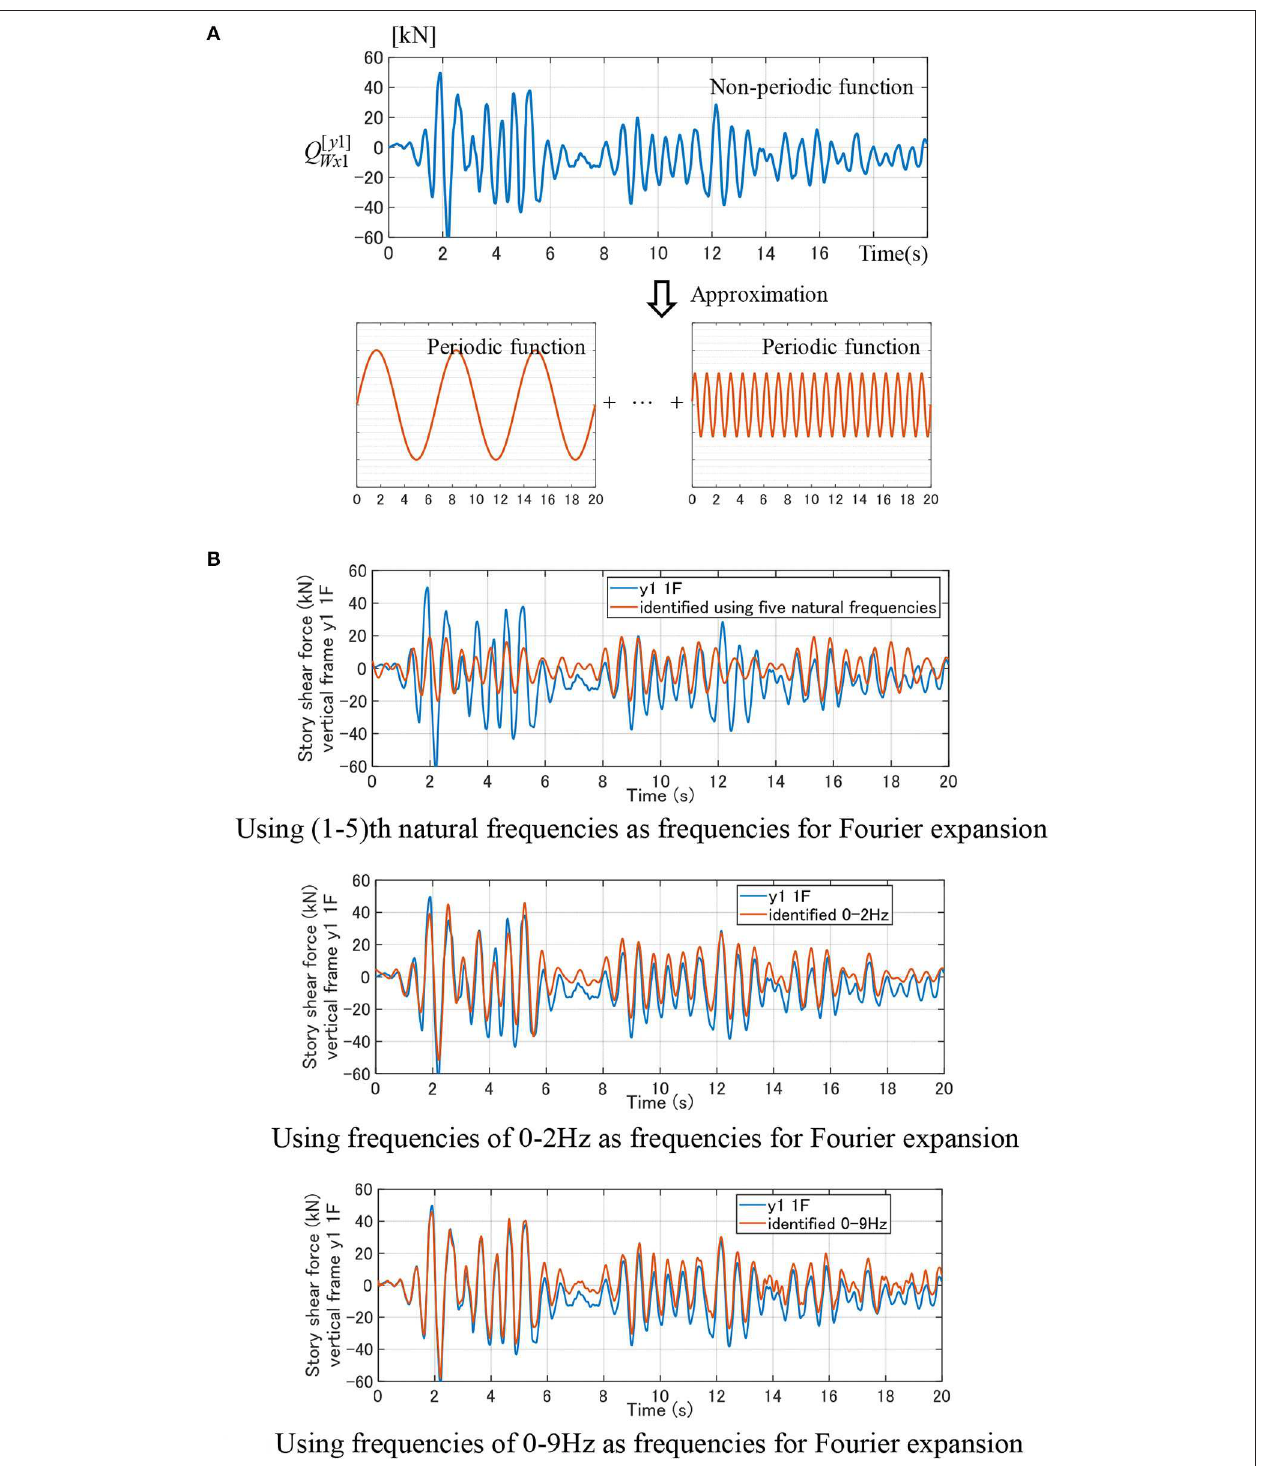
FIGURE 3 | Fourier expansion of story shear force in vertical frame and its accuracy investigation depending on employed frequencies for Fourier expansion. (A) Fourier expansion of story shear force in vertical frame. (B) Accuracy investigation in terms of frequencies for Fourier expansion. (i) Using (1–5)th natural frequencies as frequencies for Fourier expansion. (ii) Using frequencies of 0-2Hz as frequencies for Fourier expansion. (iii) Using frequencies of 0–9Hz as frequencies for Fourier expansion.